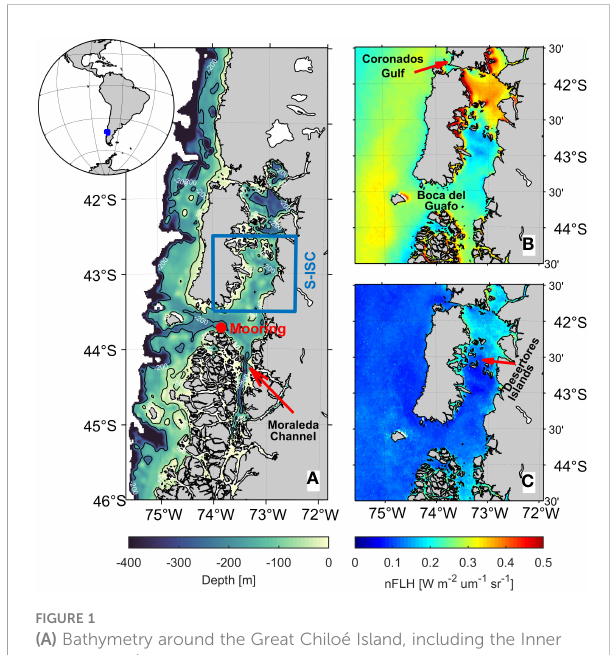
FIGURE 1 (A) Bathymetry around the Great Chiloe ́ Island, including the Inner Sea of Chiloe ́ (ISC) and the study region, the southern part of ISC (S- ISC, enclosed by a blue square); source: ETOPO1 (https://www. ngdc.noaa.gov/mgg/global/); the inlet at the upper-left corner shows the location of ISC within South America. B, C ) Climatological mean and standard deviation fi elds of normalized fl uorescence line height (nFLH) [W m -2 µm -1 sr -1 ] for summer (DJF 2003-2019), respectively. The main geographical features mentioned in this study are